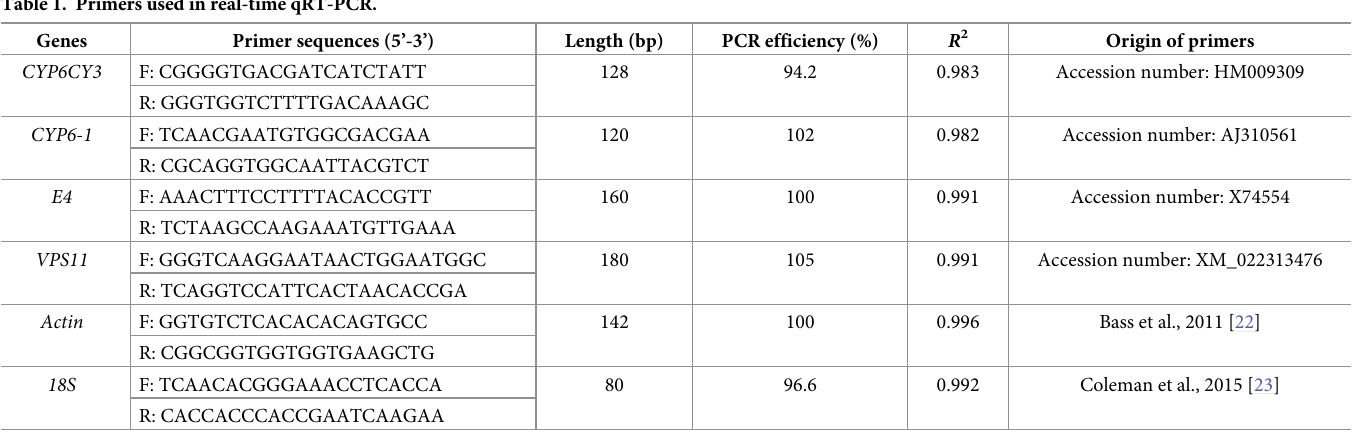
Table 1. Primers used in real-time qRT-PCR. Genes Primer sequences